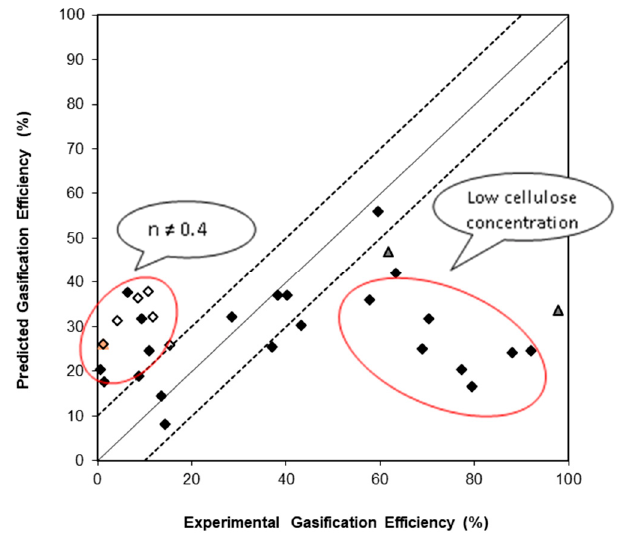
Figure 9. Predicted vs. experimental gasification efficiency of the SCWG of cellulose. Experiments with n < 0.4 ( ♦ ), n > 0.4 ( ◊ ) and experiments with KOH ( ▲ ).